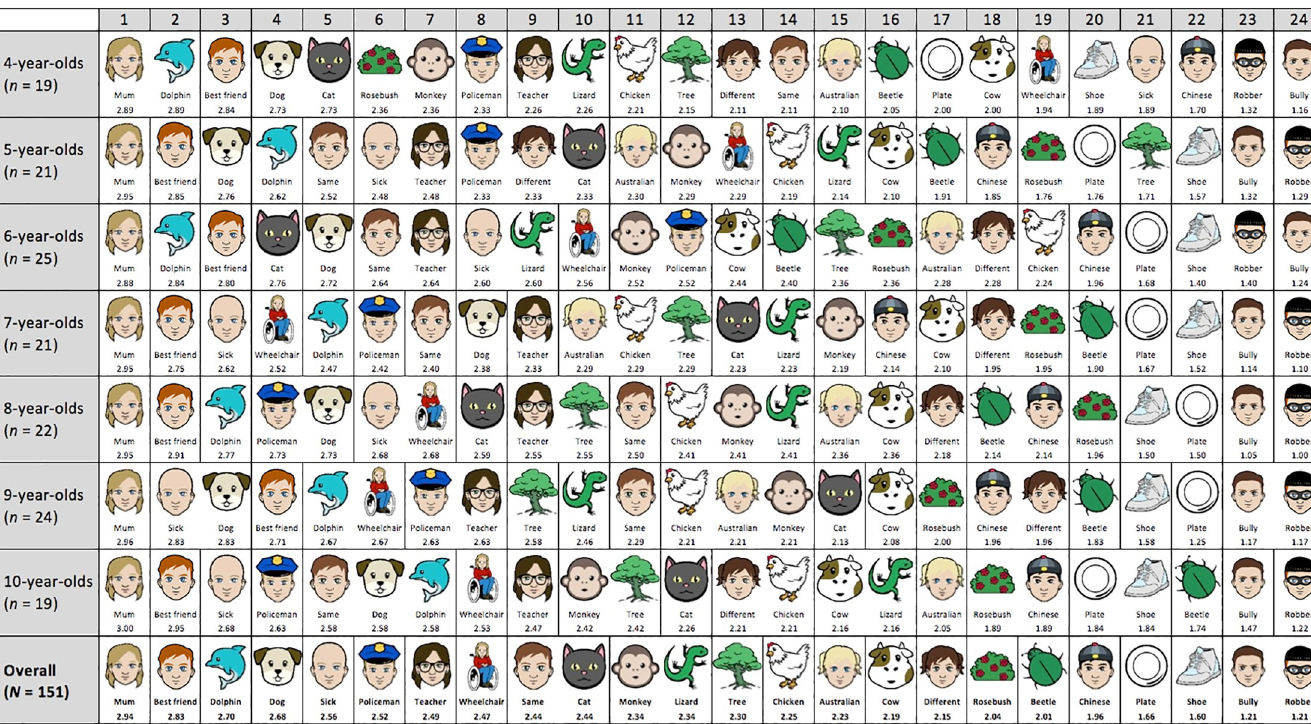
Fig 3. Summary of children’s levels of moral concern towards each entity across age groups. White bars indicate the proportion of ‘not caring at all’ responses; grey bars indicate the proportion of ‘caring a little’ responses, and black bars indicate the proportion of ‘caring a lot’ responses. Red lines indicate linear effects of age. Targets with significant age effects are marked with an asterisk.